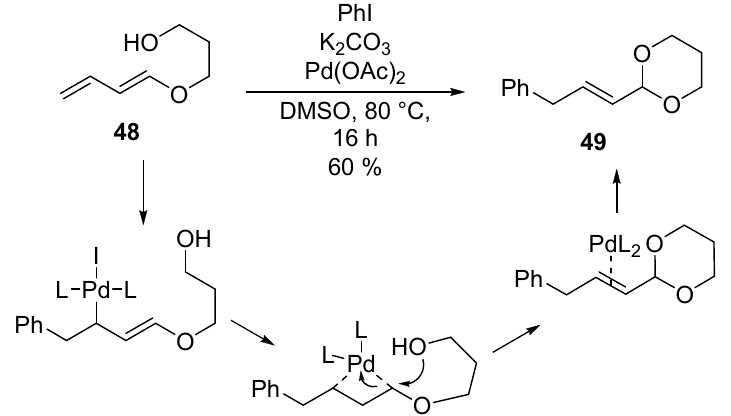
Scheme 27. Reaction mechanism of compound 49 synthesis.